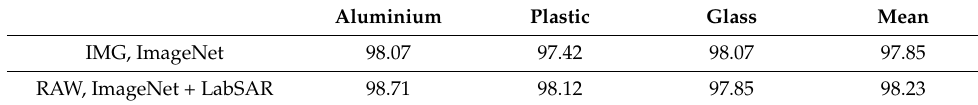
Table 5. Per-class AP performance of the best IMG and RAW models on the test